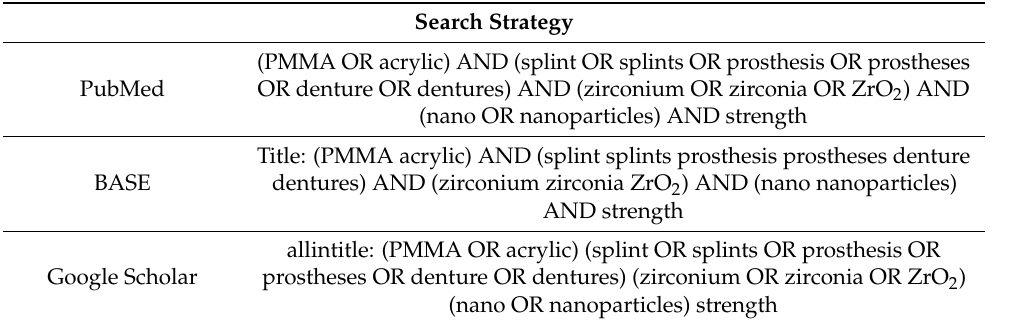
Table 1. Search strategies used for identification of